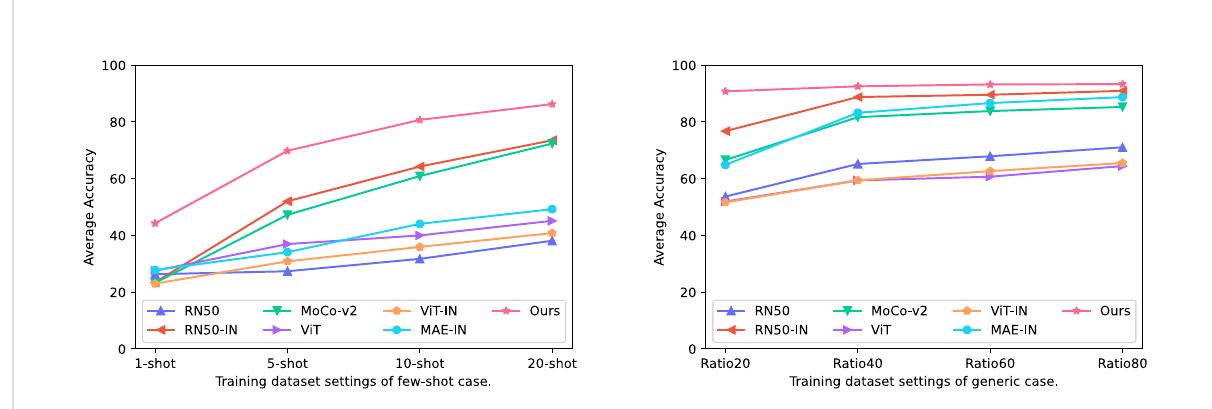
FIGURE 7 Curves of average testing accuracy mAcc of different methods in various training dataset modes over the 12 plant disease